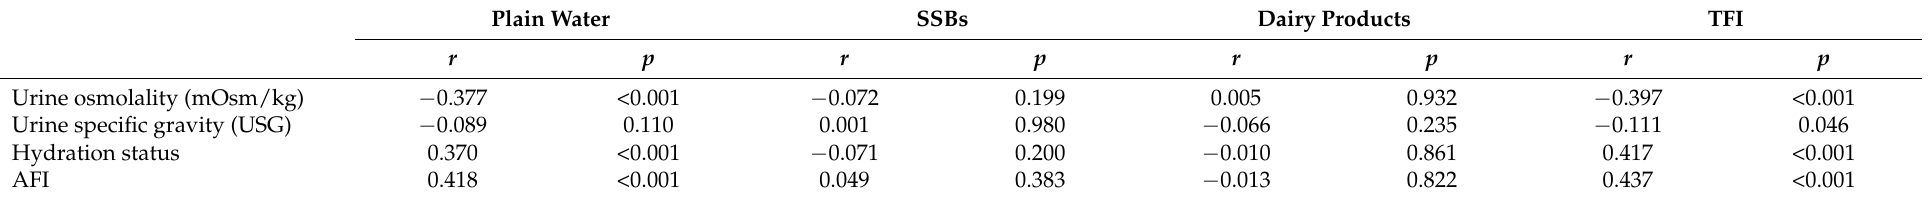
Table 7. Correlations between fluid intake, urine biomarkers, hydration status, and